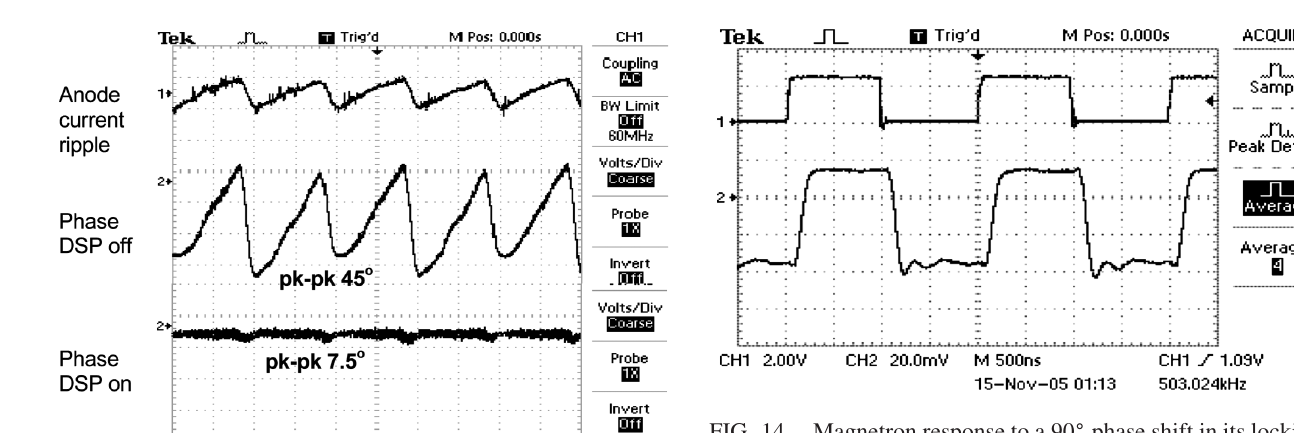
FIG. 14. Magnetron response to a 90 (cid:1) phase shift in its locking signal.